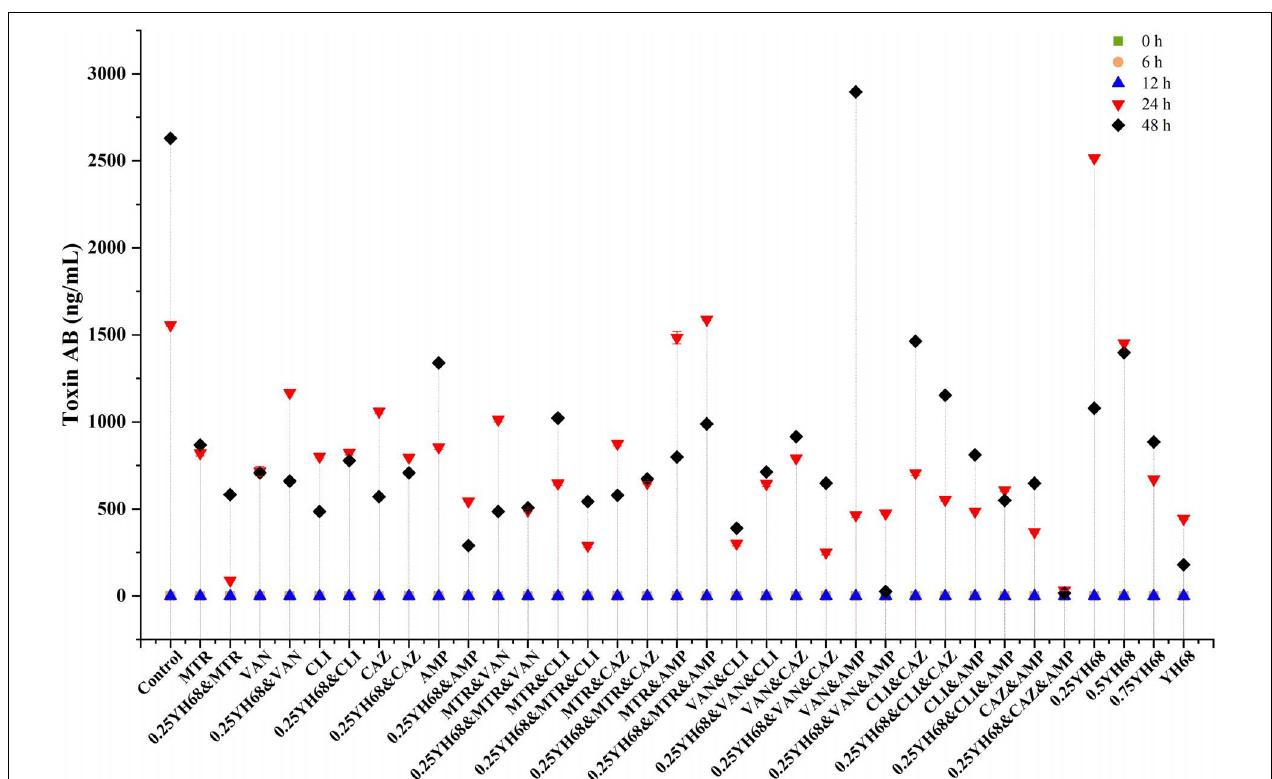
FIGURE 4 | Effects of different combinations on toxin A/B production by C. difficile ATCC